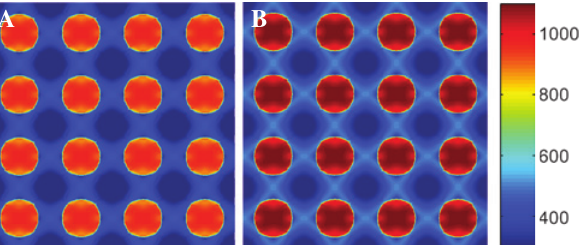
Figure 6: Effective stress fields at applied transverse strain of 1.5% at strain rates of (A) 0.1/s and (B) 1/s.